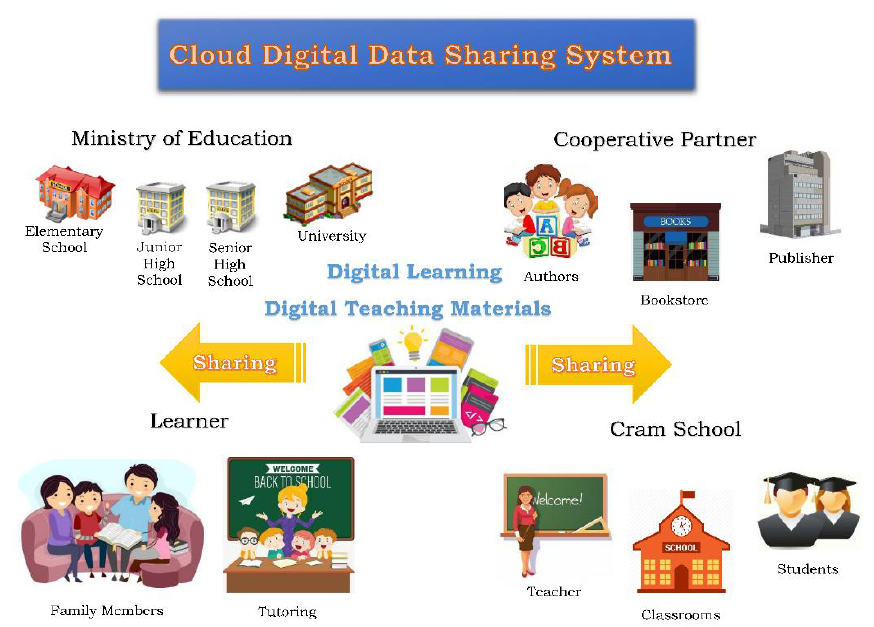
Figure 1. Access diagram for the cloud-based digital sharing system. Table 1. Symbol definitions and parameters.